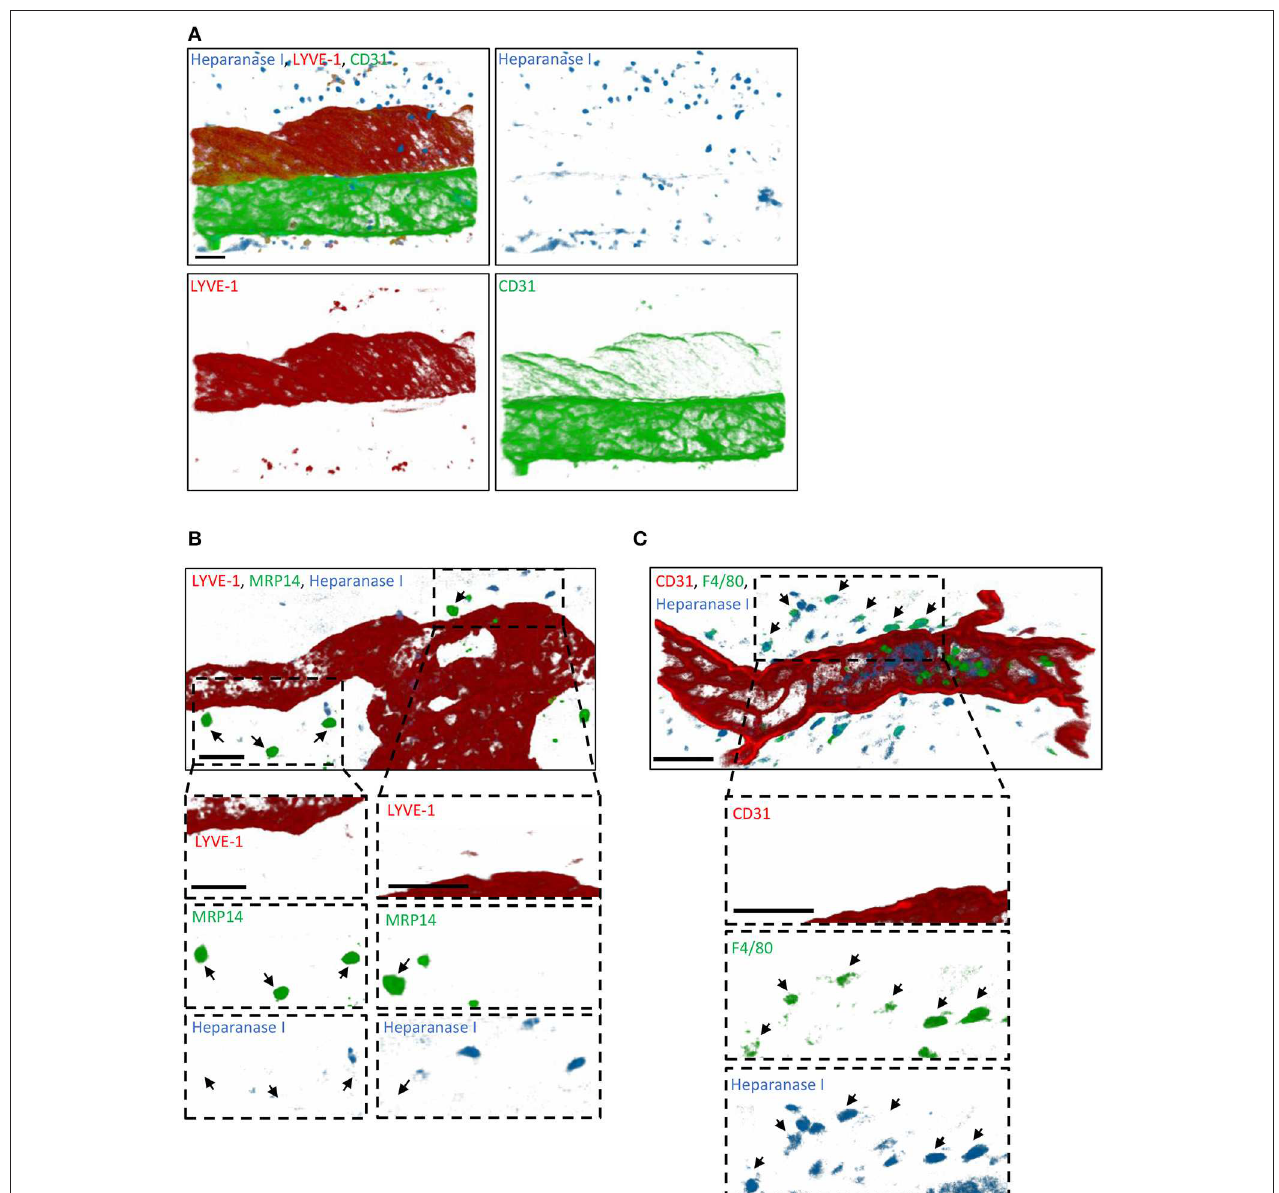
FIGURE 7 | Cellular source of Heparanase I in inflamed cremaster muscles. Mouse cremaster muscles were stimulated with TNF (i.s. 300 ng) followed by whole-mount immunostaining of the tissues with fluorescently labeled antibodies to reveal the HS-degrading enzyme Heparanase I, the lymphatic and/or blood vasculatures, and neutrophils/macrophages prior to the visualization of the samples by confocal microscopy. (A) Representative 3D-reconstructed confocal images of a region of the cremaster muscle showing that Heparanase I (blue) is not associated with cremaster lymphatic (LYVE-1, red) or blood (CD31, green) vasculatures but with cells present within the interstitial tissue. (B) Representative 3D-reconstructed confocal images of a region of the cremaster immunostained for lymphatic vessels (LYVE-1, red), neutrophils (MRP14, green) and Heparanase I (blue). Two magnified regions (dotted box) within the main image are provided in the bottom panels demonstrating that Heparanase I is neither associated with lymphatic endothelial cells nor neutrophils (arrows). (C) Representative 3D-reconstructed confocal images of a region of the cremaster immunostained for endothelial cells (CD31, red), macrophages (F4/80, green), and Heparanase I (blue). A magnified region (dotted box) within the main image are provided in the bottom panels demonstrating that Heparanase I is strongly associated with macrophages (arrows). Bar = 40 µ m. Images are representative pictures from at least 5 vessels/animals, with at least 4 animals.